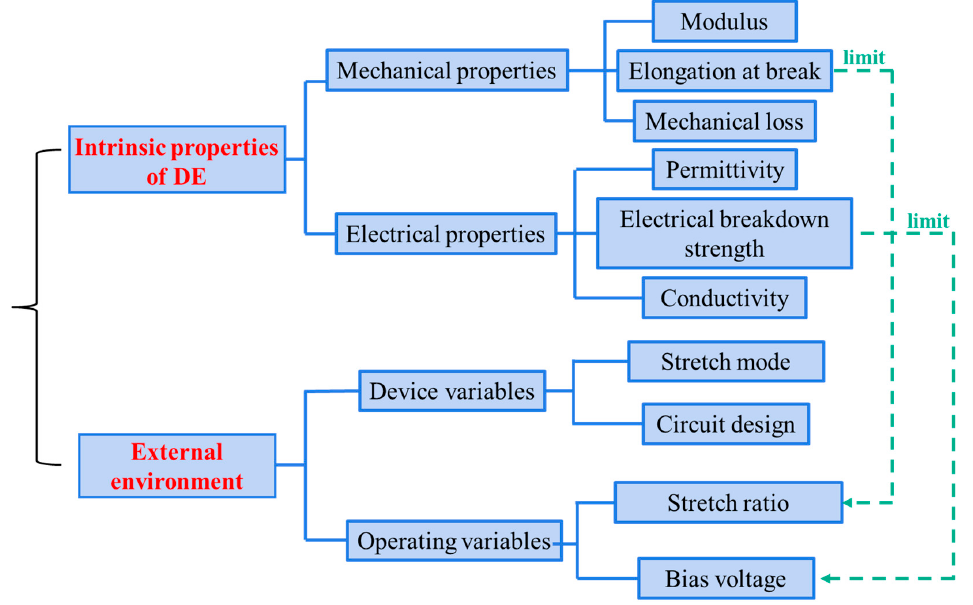
Figure 2. Influencing factors on the energy-generation performances of the